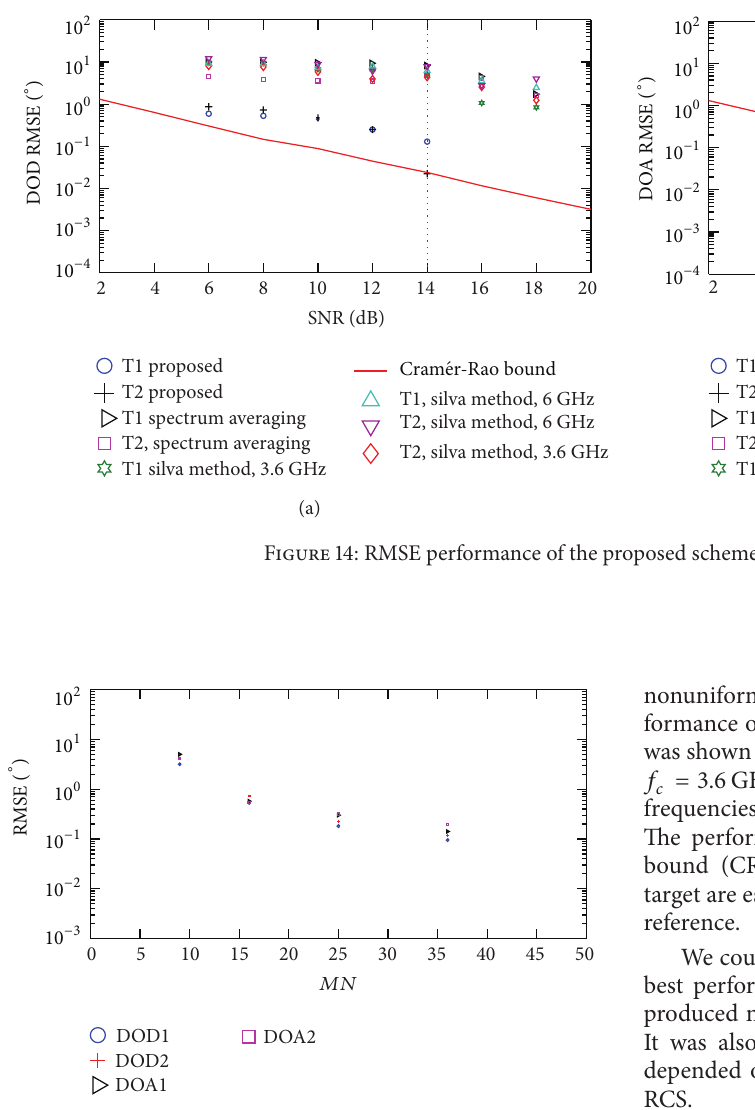
Figure 15: RMSE of the proposed scheme against MN (bandwidth = 1000 MHz, L = 2, SNR = 8 dB, and target =